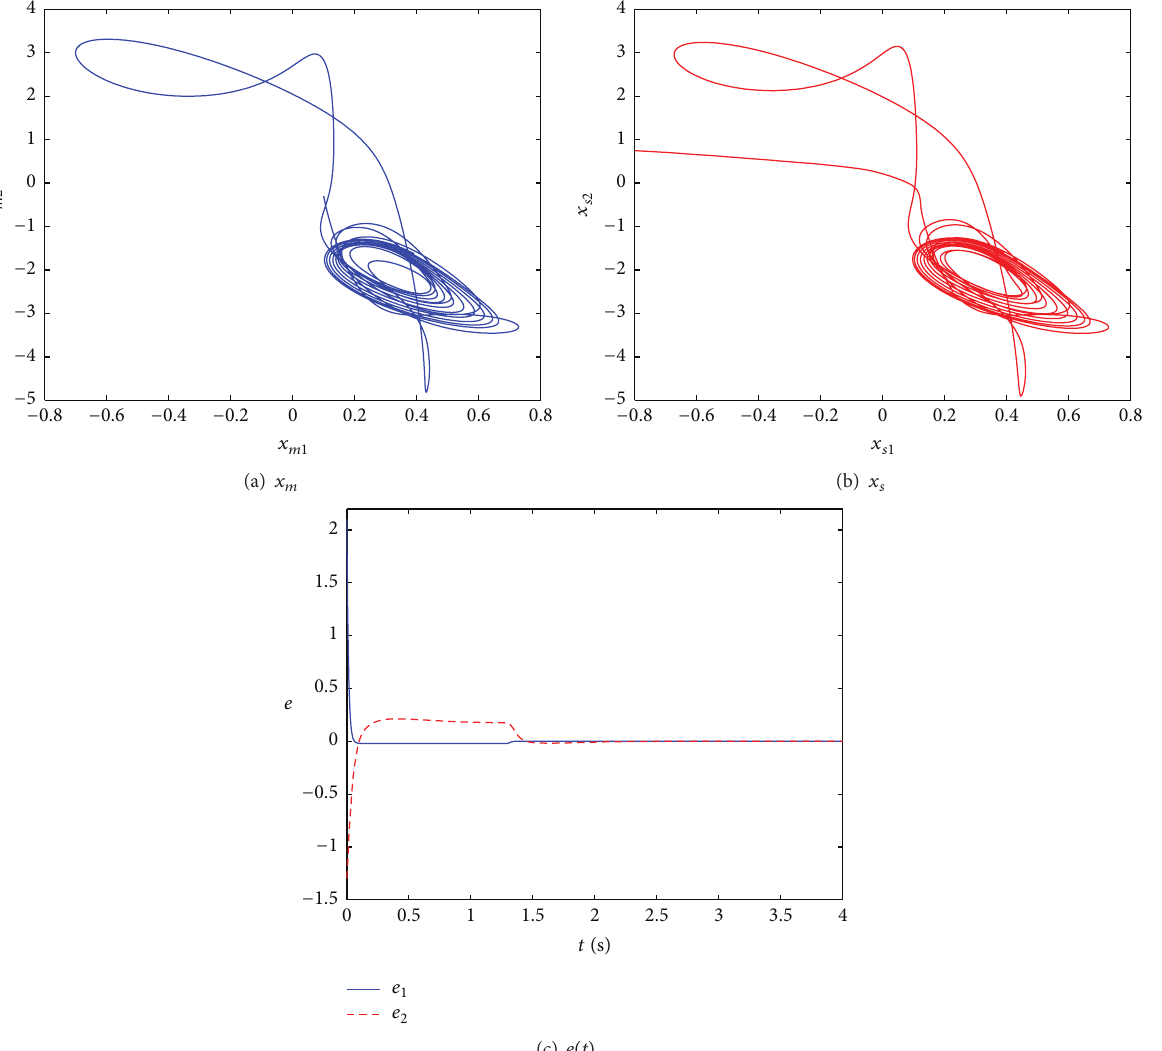
Figure 2: Behavior of the drive and response systems with controller: (a) phase trajectory of drive system, (b) phase trajectory of response system, and (c) synchronization